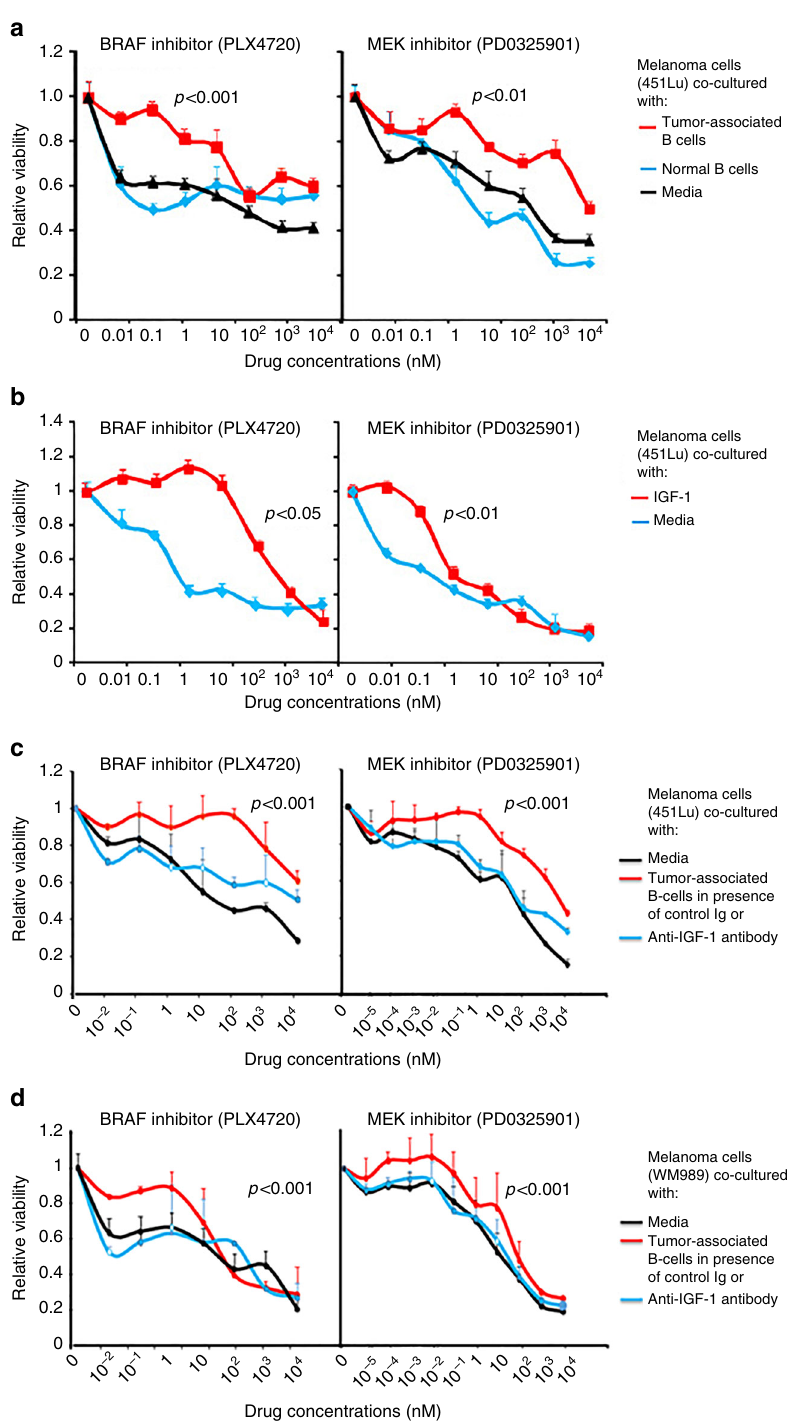
Fig. 5 Melanoma cells co-cultured with TAB cells or recombinant IGF-1 are resistant to signaling inhibitors. a Melanoma cells (451Lu) co-cultured with TAB cells for 4 – 5 days are resistant to subsequent BRAFi (PLX4720) and MEKi (PD0325901) treatment ( red lines ) as compared with tumor cells cultured in the presence of NB cells ( blue lines ) or media control only ( black lines ). Co-cultured tumor cells were treated with drugs in triplicates for 72 h and viability was determined using the AlamarBlue assay. Results are expressed as relative viability of melanoma cells and drug responses are compared with appropriate controls. Data represents mean + SE of triplicate samples and p values ( t -test) as indicated are for drug doses 0.1 to 10 nM of BRAFi and 0.01 nM to 1 nM of MEKi. b Melanoma cells treated with recombinant IGF-1 show resistance to BRAFiand MEKi. Melanoma cells (451Lu) were treated every day for a total of 5 days with recombinant IGF-1 (25 ng/ml; red lines ), then harvested and their dose responses to BRAFiand MEKi determined as above. Results are compared with untreated melanoma cells as controls ( blue lines ). c , d Melanoma cells (451Lu ( c ) and WM989 ( d )) co-cultured with TAB cells for 4 days in presence of anti-IGF-1 neutralizing antibody ( blue lines ) or media control ( black lines ) are sensitive to subsequent BRAFi and MEKi treatment as compared with cultures incubated with control antibody ( red lines